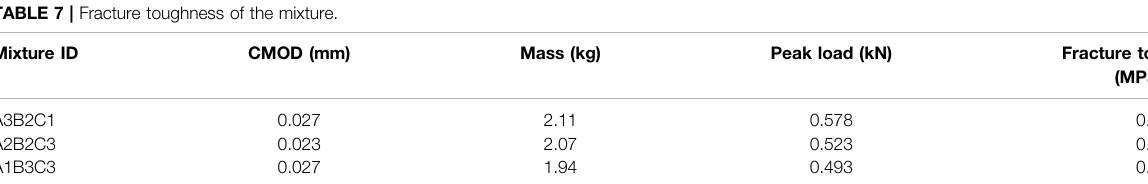
TABLE 7 | Fracture toughness of the mixture.